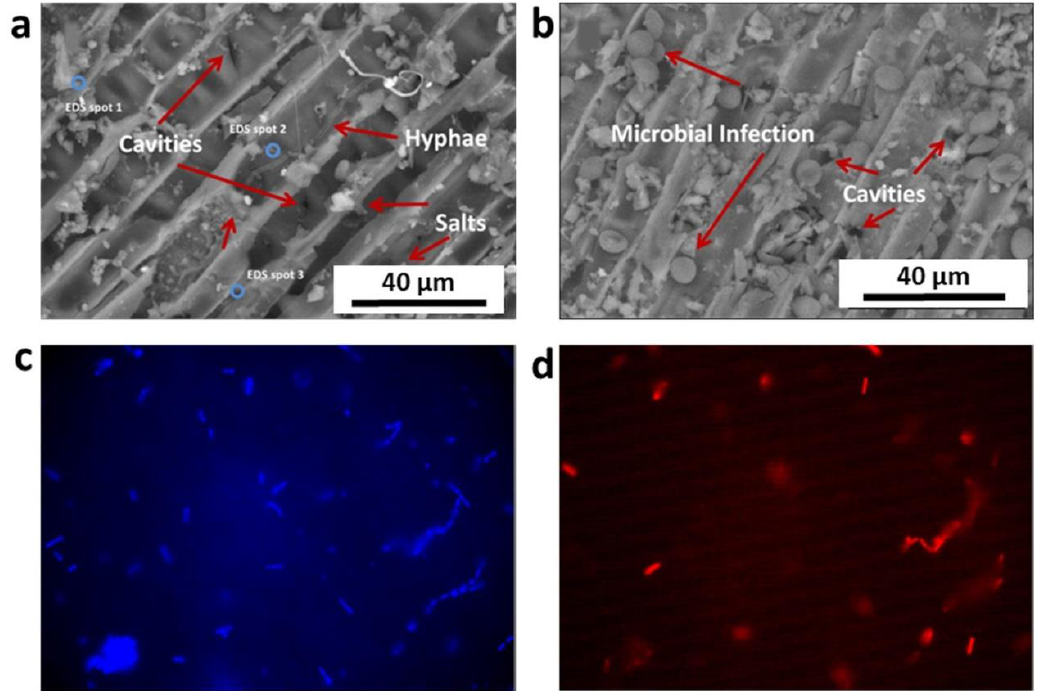
Figure 5. ( a , b ) SEM images (magnification 3000×) of sample #1 (pure core wooden sample, inner the statue). Fungal hyphae (panel ( a )) and spores (panel ( b )) are visible. ( c , d ) Images of FISH assays under the epifluorescence microscope using the DAPI-stain for all microbial cells (blue, panel ( c )) and the Cy3-labelled EUB probe for Bacteria (red, panel ( d )) (magnification 1000×).